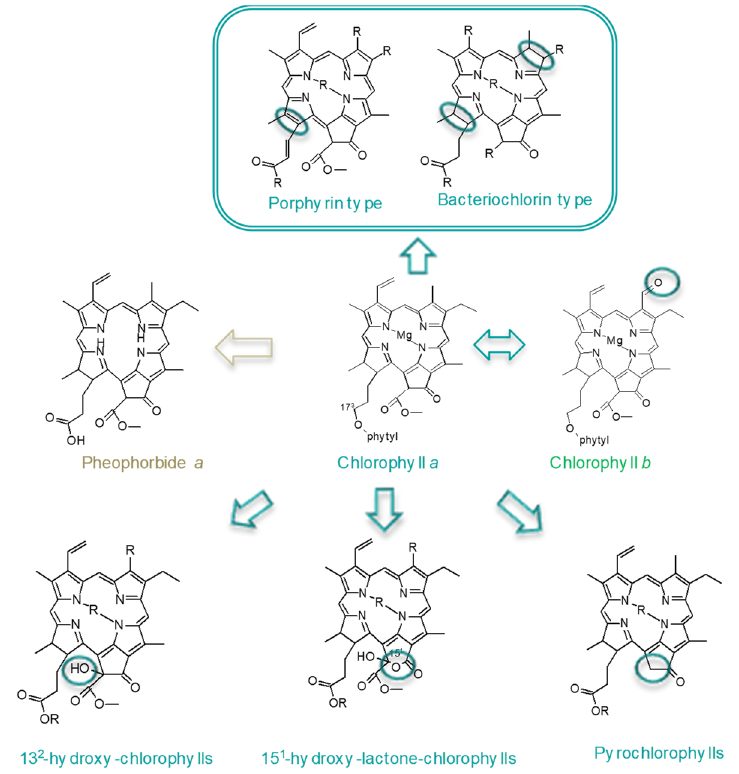
Figure 2. Main chlorophyll structures present in organisms or food due to natural metabolism or during processing or storage. during processing or